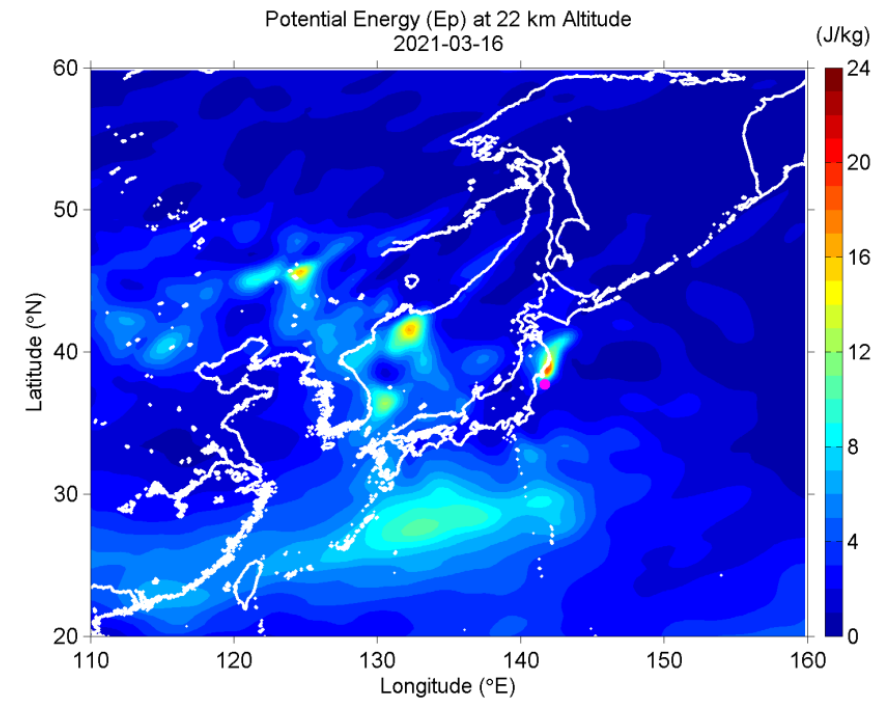
Figure 11. Same as in Figure 8, but for the second EQ.